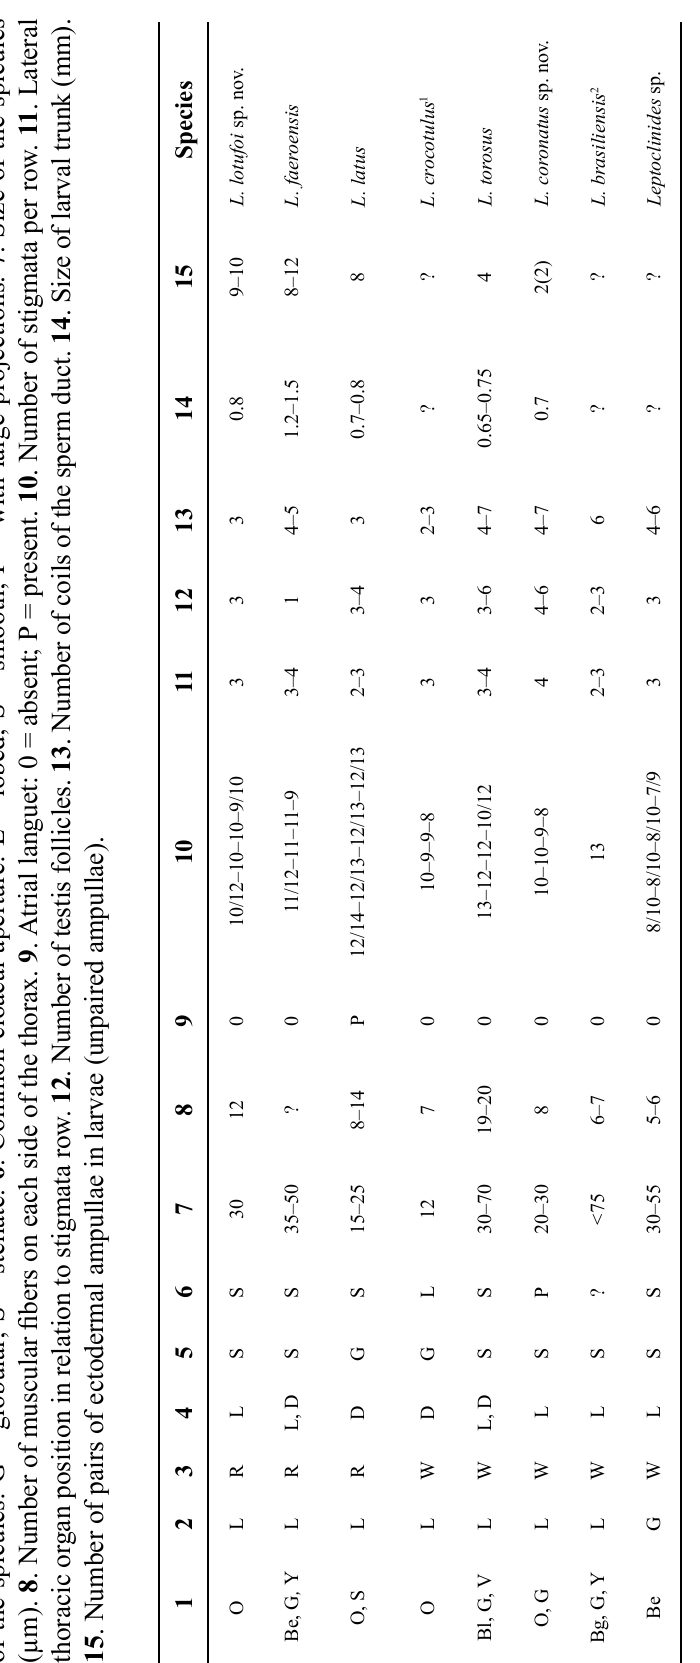
e . b l il a a a v on